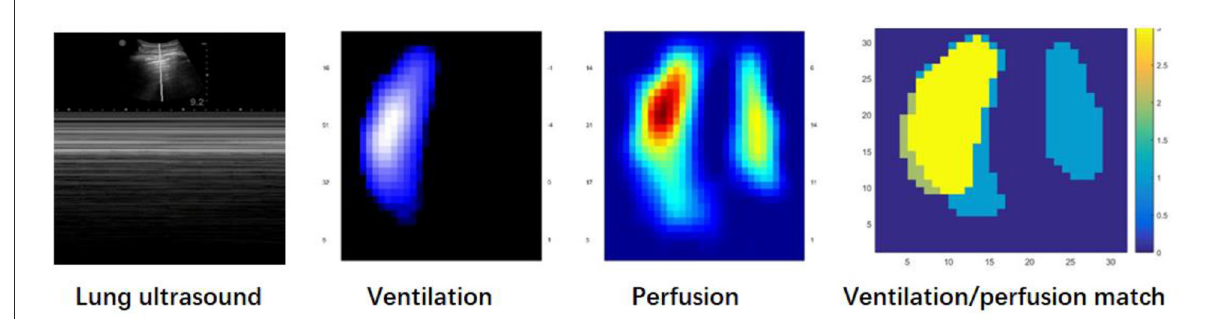
FIGURE2 The lung ultrasound and EIT monitoring (hypoxemia occurs). 1. Lung ultrasound imaging with a convex probe (5 MHz) showed the absence of gliding sign, confirmed by the Barcode sign in M-mode at the onset of hypoxemia. 2. Functional electrical impedance tomography (EIT) images of ventilation and perfusion distribution at the onset of hypoxemia. Low-ventilated regions are marked in dark blue and high-ventilated regions in white. Regions with high perfusion are marked in red and low perfusion in blue. A massive ventilation defect was found in the left lung in which perfusion was maintained, and perfusion and ventilation matched the image at the onset of hypoxemia. Regions with high ventilation and low perfusion (indicate dead space) are marked in light green; low ventilation and high perfusion regions (indicate intrapulmonary shunt) in light blue; good ventilation-perfusion matching in yellow.